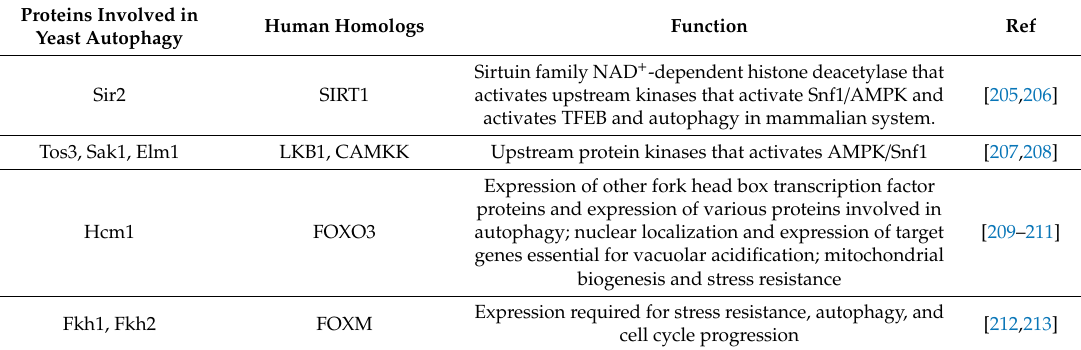
Table 5. Conservation of core autophagy related proteins and autophagy regulators from yeast to